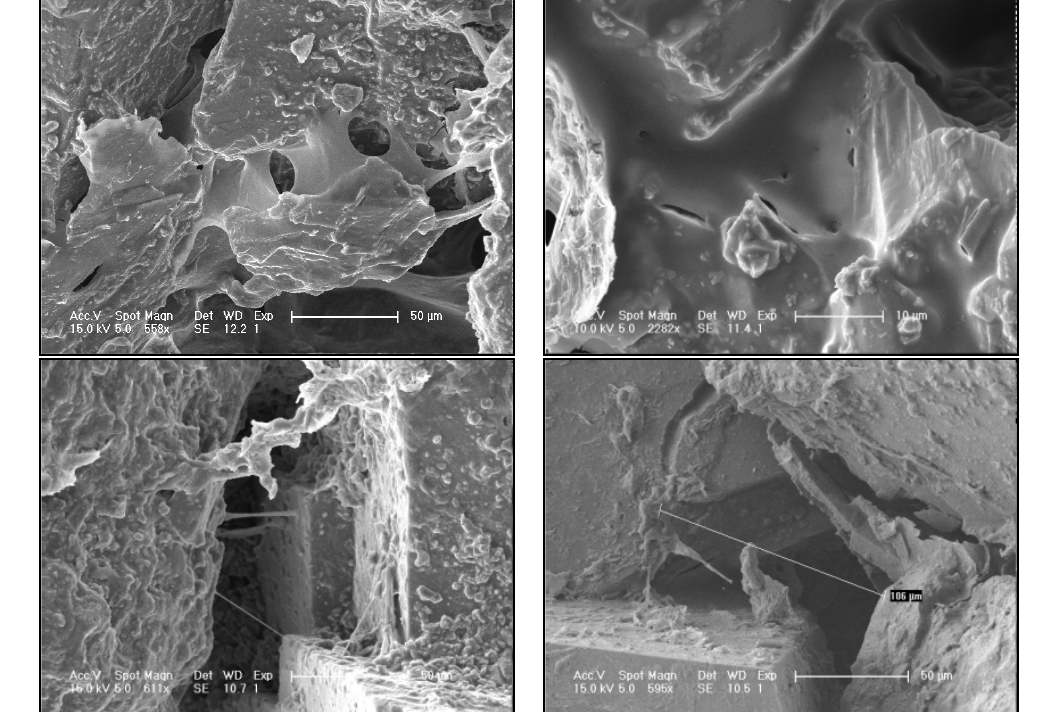
Figure 7. The gel morphology of unconsolidated cores.